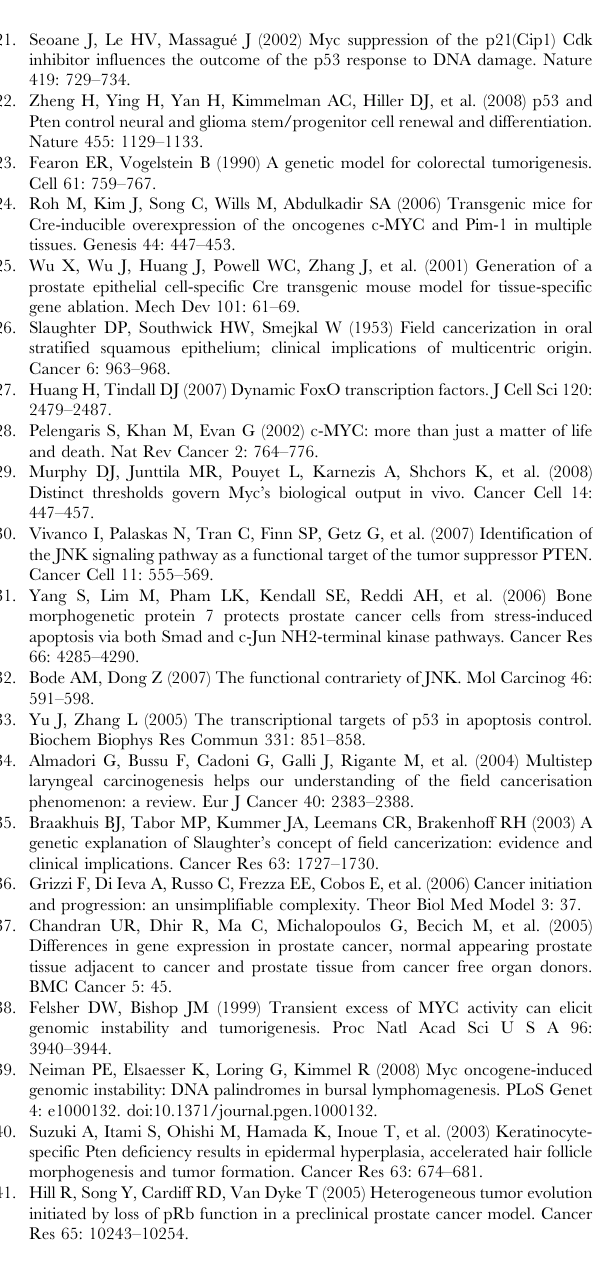
Figure S1 Histopathology of PbCre4;Pten f/f and PbCre4;Z-MYC;P- ten f/f tumors at different ages. PbCre4;Z-MYC;Pten f/f mice